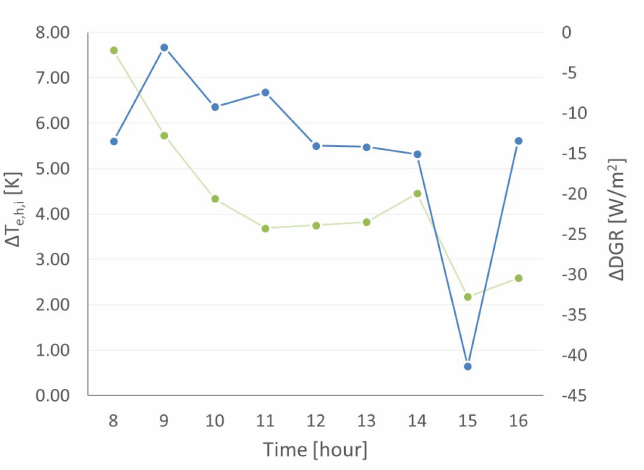
Figure 18. Average hourly temperature differences ∆ T e , h , i and average hourly values of daily incident radiation ∆ Q h , i for measurements with collector rotation and without collector rotation 21 March 2019 and 2 April 2019 for system with active rotation, 29 March 2019 and 30 March 2019 for static system without rotation of thermal collectors.